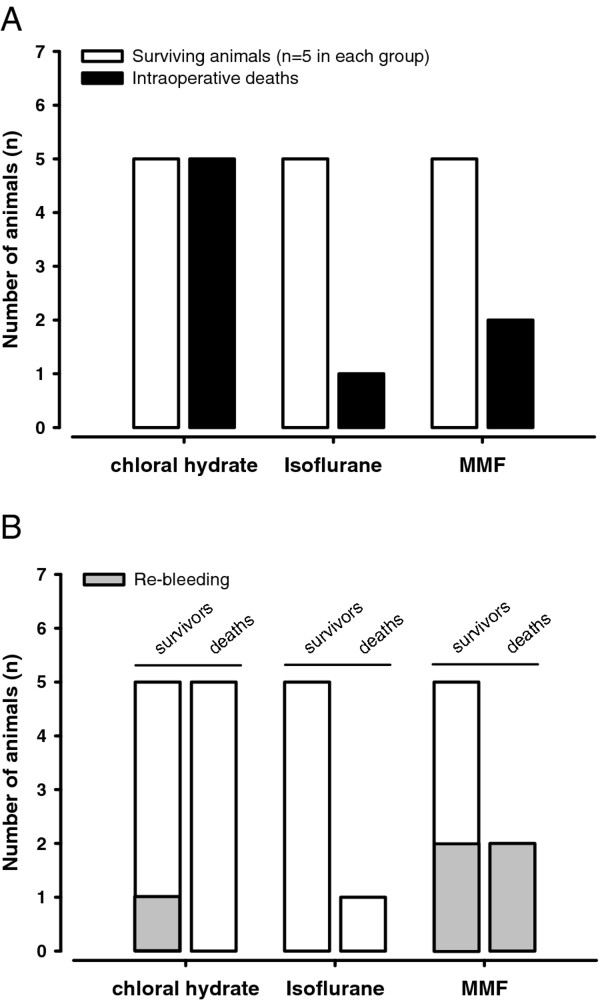
(A) Total number of operated rats per group stratified by survival. The number of animals per group was increased until n = 5 rats survived the 3 hour post-operative observation period. Mortality in animals anesthetized with chloral hydrate, isoflurane, or MMF was 50%, 17%, and 29%, respectively. (B) Number of animals which suffered a re-bleeding following SAH stratified by animals surviving (survivors) or not surviving (deaths) the post-operative observation period of 3 hours. Numbers of animals which died from anesthesia-induced complications are given in gray.